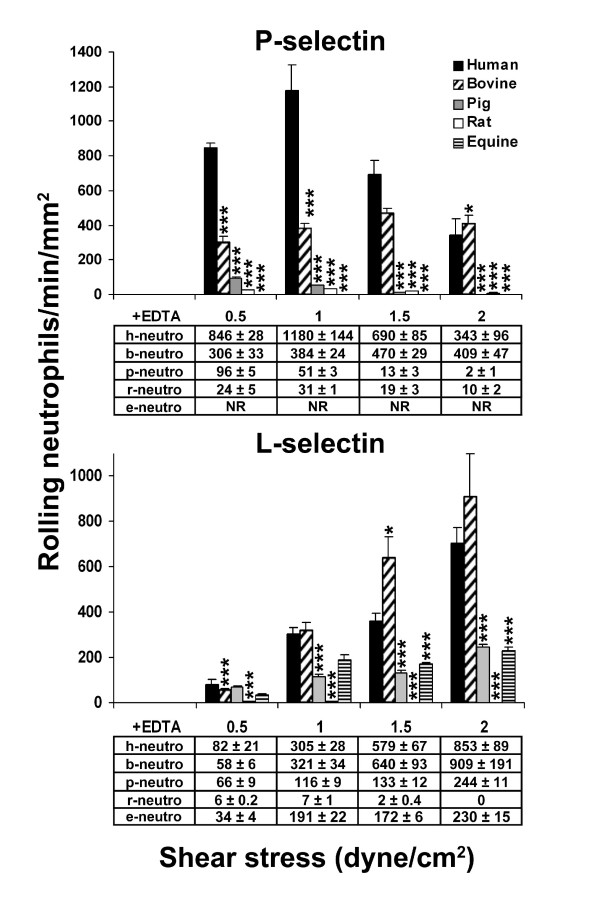
L- and P-selectin-dependent recruitment of neutrophils is species-dependent. Human, bovine, porcine, rat and equine neutrophils were perfused under 0.5–2.0 dynes/cm2 on human P-selectin/μ or on human L-selectin/μ chimera adsorbed on coverslips precoated with goat anti-human IgM antibody. PSGL-1-dependent neutrophil rolling was abolished in presence of 10 mM EDTA. Cell recruitment was assessed at 4–5 min of perfusion. Results represent the mean ± SEM of 3–4 experiments (*, P < 0.05, ***, P < 0.001).